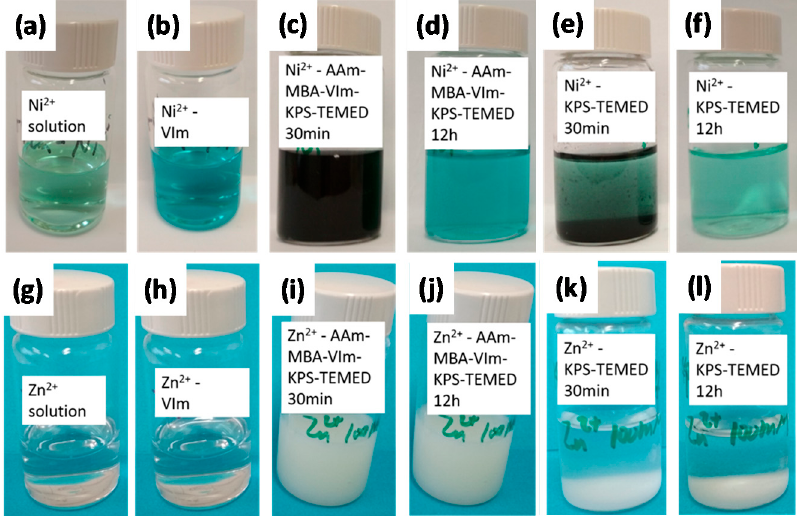
Figure 2. ( a – l ) The color and turbidity change during polymerization of P(AAm- co -VIm)–M 2+ dual-crosslink gels (M: Ni or Zn).